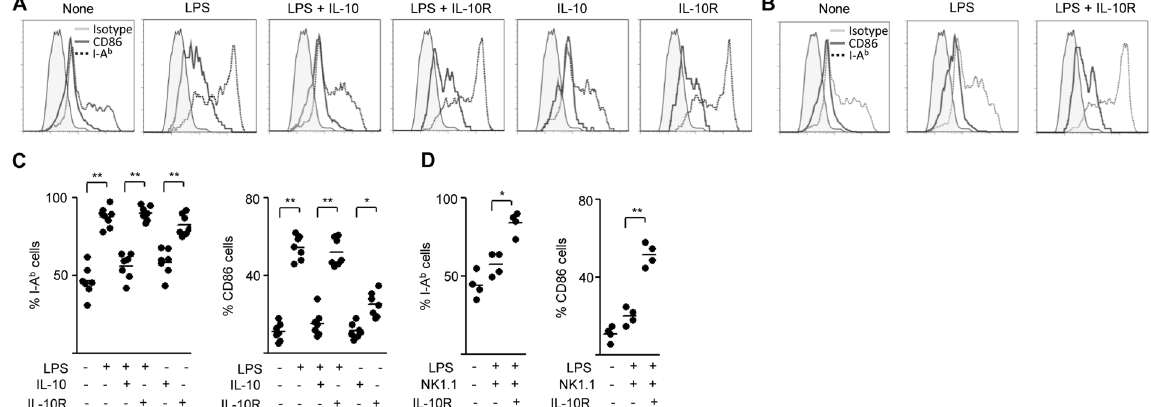
Figure 2. IL-10 rescues pregnancy failure upon NK cell depletion in FLT3-treated dams modulating decidual DC phenotype. ( A ) Representative flow cytometric histograms showing I-A b and CD86 staining in gated decidual CD11c + cells exposed to 1 μ g/ml LPS in the presence or absence of IL-10 (10 ng/ml) or IL-10R (10 μ g/ ml). ( B ) IL-10 − / − CD11c + cells were co-cultured with IL-10 + / + NK1.1 + cells and exposed to 1 μ g/ml LPS in the presence or absence of IL-10R (10 μ g/ml), and flow cytometric histograms are shown, which are representative of four mice. ( C ) Summary data showing the percentages of I-A b and CD86 in gated decidual CD11c + cells compared to control cultures with or without LPS, IL-10 or IL-10R. Data shown are mean derived from seven mice per treatment. ( D ) Summary data showing the percentage of I-A b and CD86 in gated decidual IL-10 − / − CD11c + cells compared co-cultures with IL-10 + / + NK1.1 + cells with or without IL-10R. Data shown are mean derived from four mice per treatment. ( C , D ) * and ** denote p < 0.05 and p < 0.01 respectively, as analysed by the Tukey’s test.